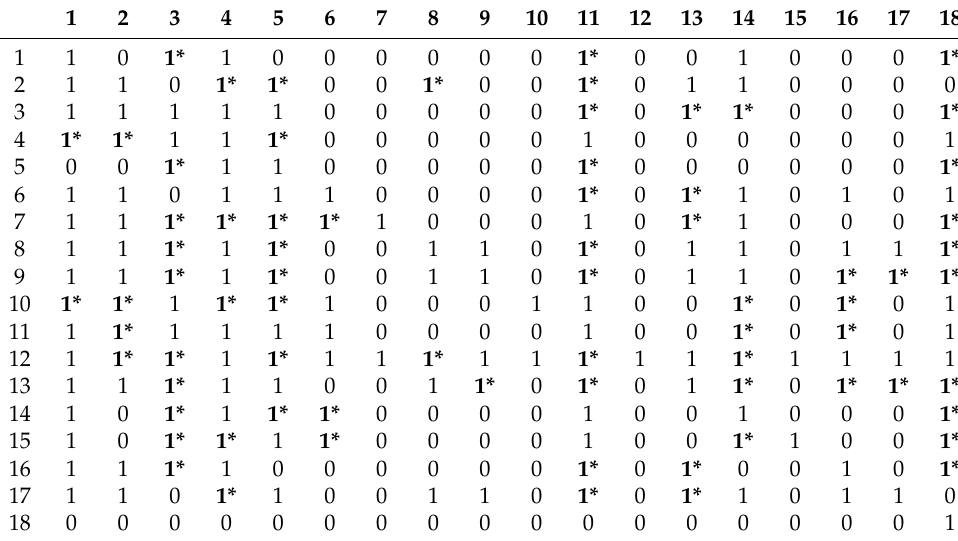
Table 5. Final reachability